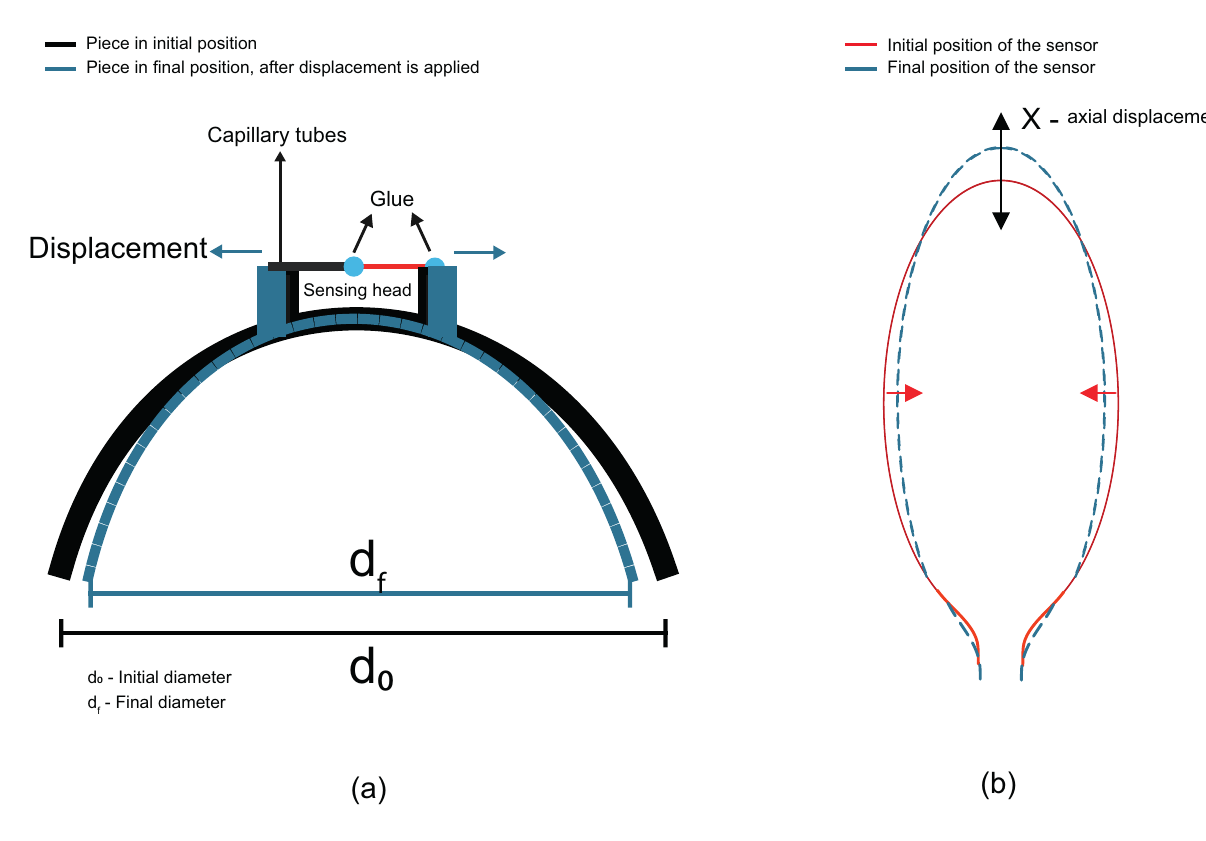
Figure 6. ( a ) Mechanism of operation of the 3D piece. ( b ) The axial strain direction that the optical fiber is submitted to displacement using the 3D